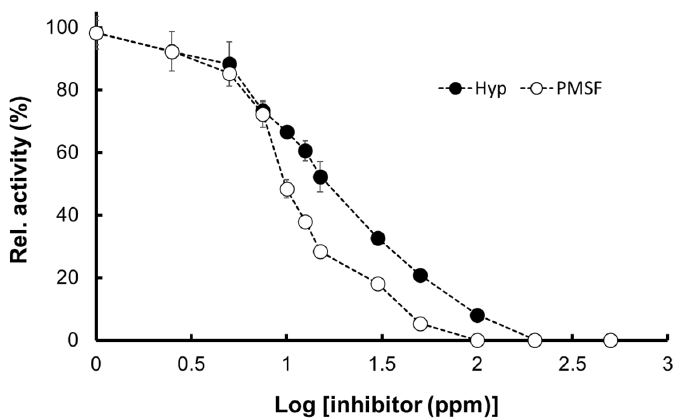
Figure 8. Relative activity of Pk-ClpP in the presence of various concentrations of hyptolide (Hyp) and a serine protease inhibitor PMSF (phenylmethylsulfonyl fluoride). The 100% relative activity was calculated from the activity without the inhibitors (not shown in the graph). The graph showed the relative activity in the presence of inhibitors with the concentration ranging from 1 nM (log 10 0 ) to 500 nM (log10 2.69 ).